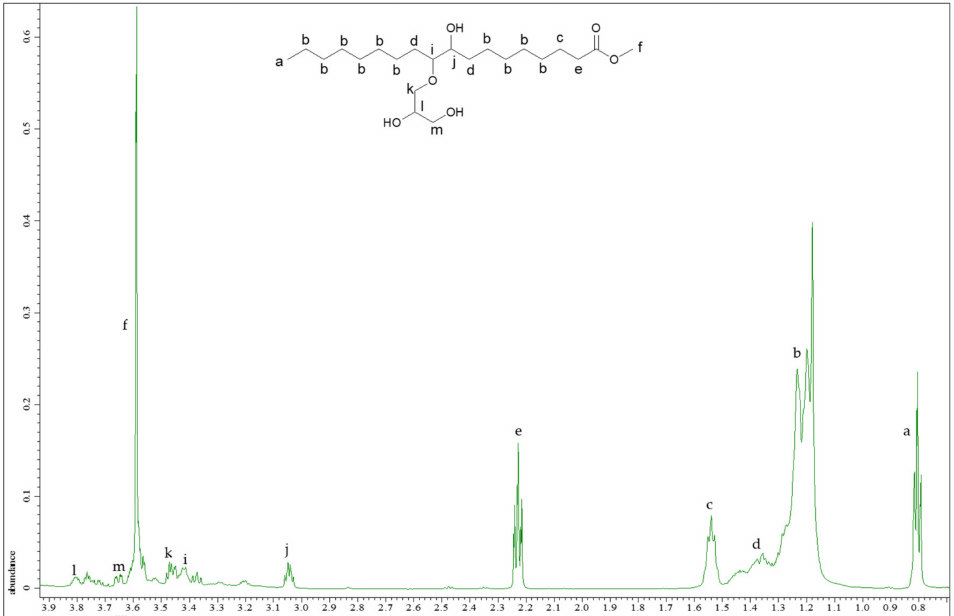
Figure 9. Proton NMR Spectra of